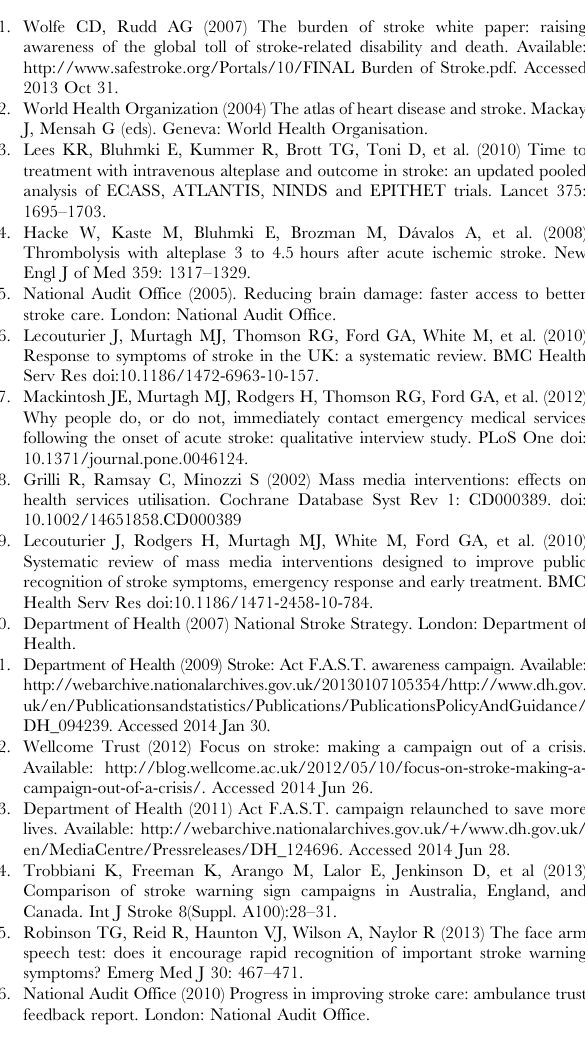
Table S1 Interval estimates of segmented regression coefficients for changes in data for different time periods (adjusted for seasonality). Figures are absolute numbers. Predicted mean at March 2009 are predicted values for data if phase 1 had not occurred. Change in level - step change in levels for data immediately after phase one (between February 2009 and March 2009). Trends refer to monthly changes in data. SA: Stroke Association; HES (Hospital Episode Statistics); A&E (accident and emergency); SITS (Safe Implementation of Throm- bolysis in Stroke). Table S2 Summary of statistically significant (p , 0.5) changes in data for different time periods (adjusted for seasonality). Figures for predicted mean at March 2009 are absolute numbers – predicted values if phase 1 had not occurred. Change in level - step change in levels for data immediately after phase one (between February 2009 and March 2009). Trends